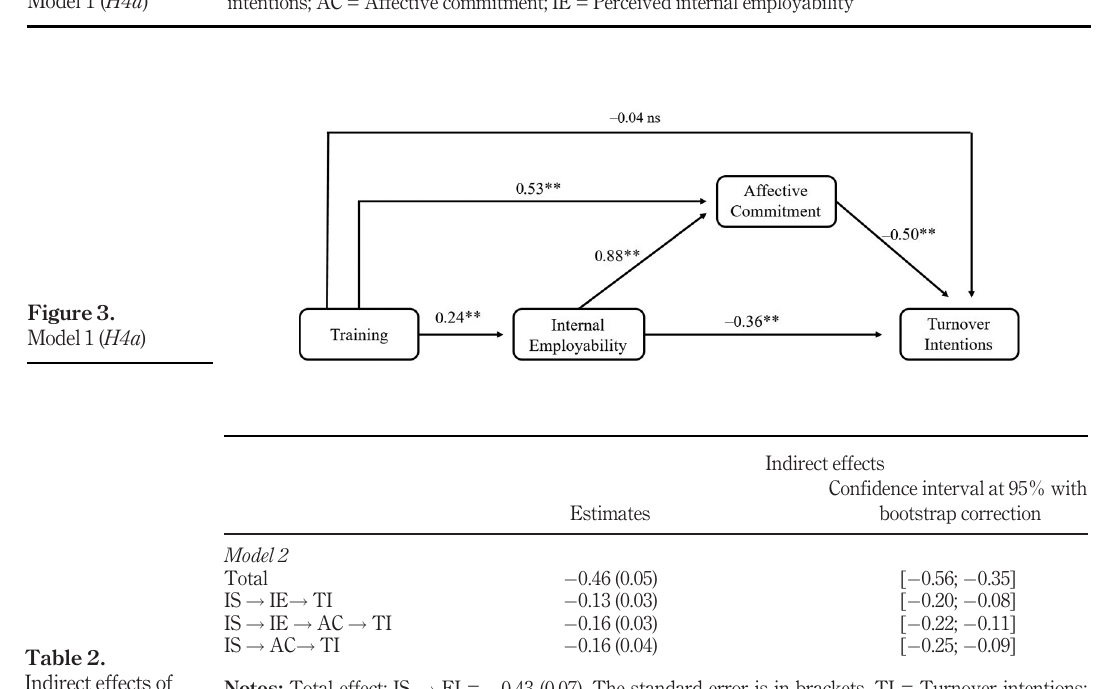
Table 2. Indirect effects of Model 2 ( H4b